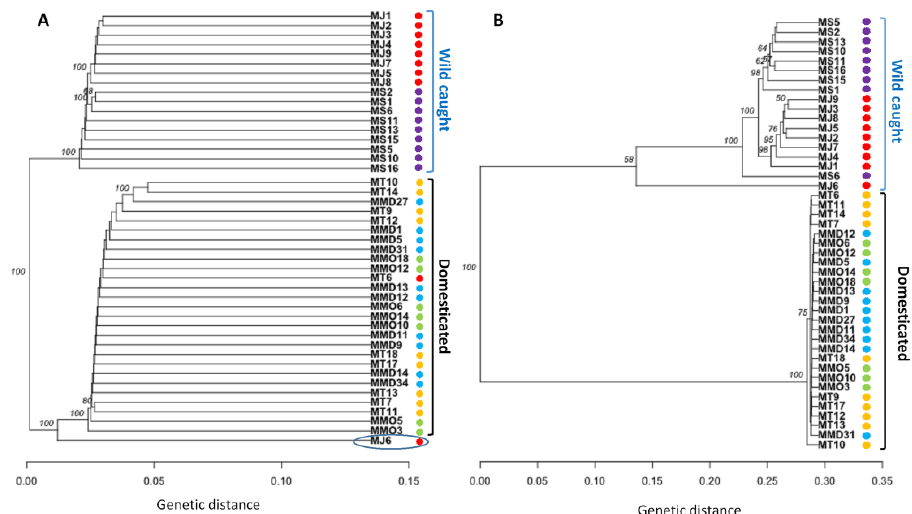
Figure 4. Neighbor-joining trees based on the Nei’s genetic distances for all SNP loci dataset ( A ) and the putatively adaptive panel of SNP loci dataset ( B ) of five broodstock populations of Penaeus monodon in the Indo-Pacific region. Branch nodes are denoted as the percentage of bootstrap support that was generated with 1000 replicates. Here, MJ indicate samples from Shizuoka, Japan (wild); MS indicate samples from Setiu Wetland, Malaysia (wild); MMD indicates samples collected from Mahajamba, Madagascar (Domesticated); MMO indicates samples from Hawaii, HI, USA (Domesticated); MT indicates samples from Petchaburi Province, Thailand (Domesticated). The numeric number next to the sample name abbreviation indicates the respective individual tag number during collection.